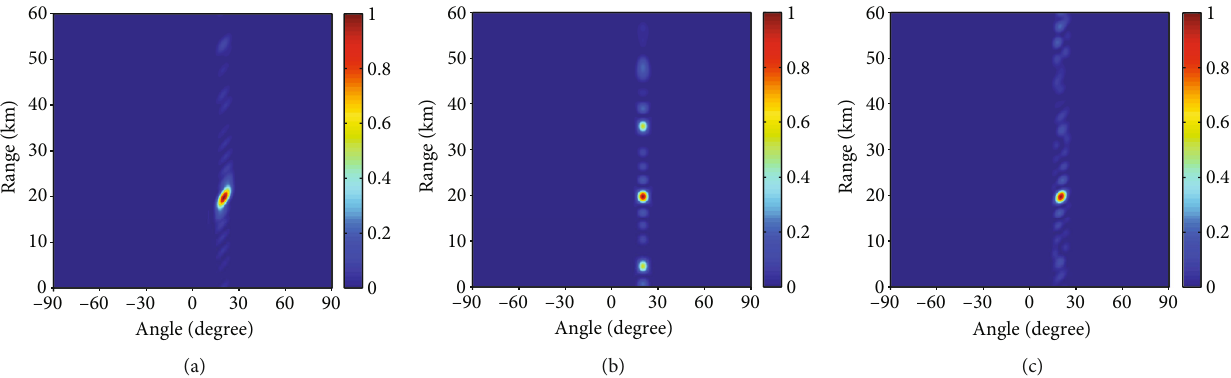
Figure 7: Transmit-receive beampatterns using MIMO radar with (a) the log-FDA, (b) the Hamming-FDA, and (c) the proposed FDA.